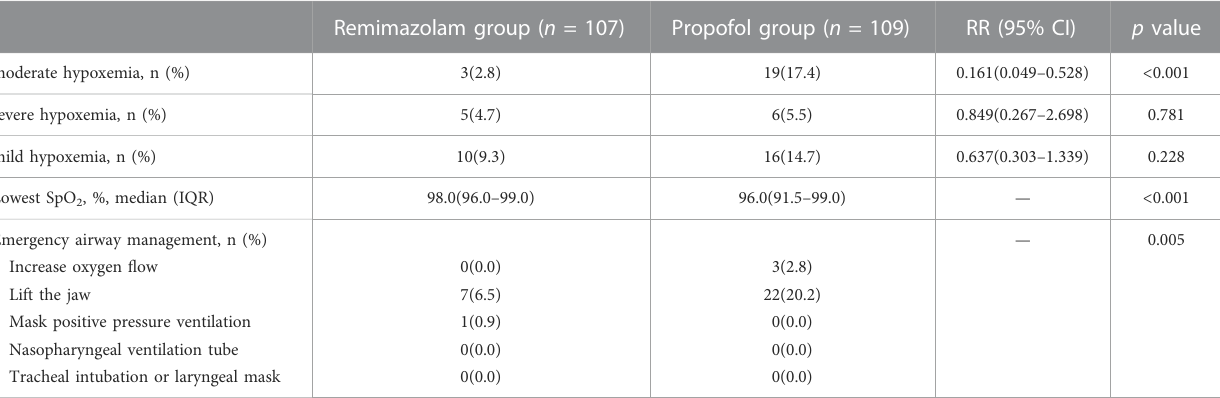
TABLE 2 Comparison of hypoxemia and